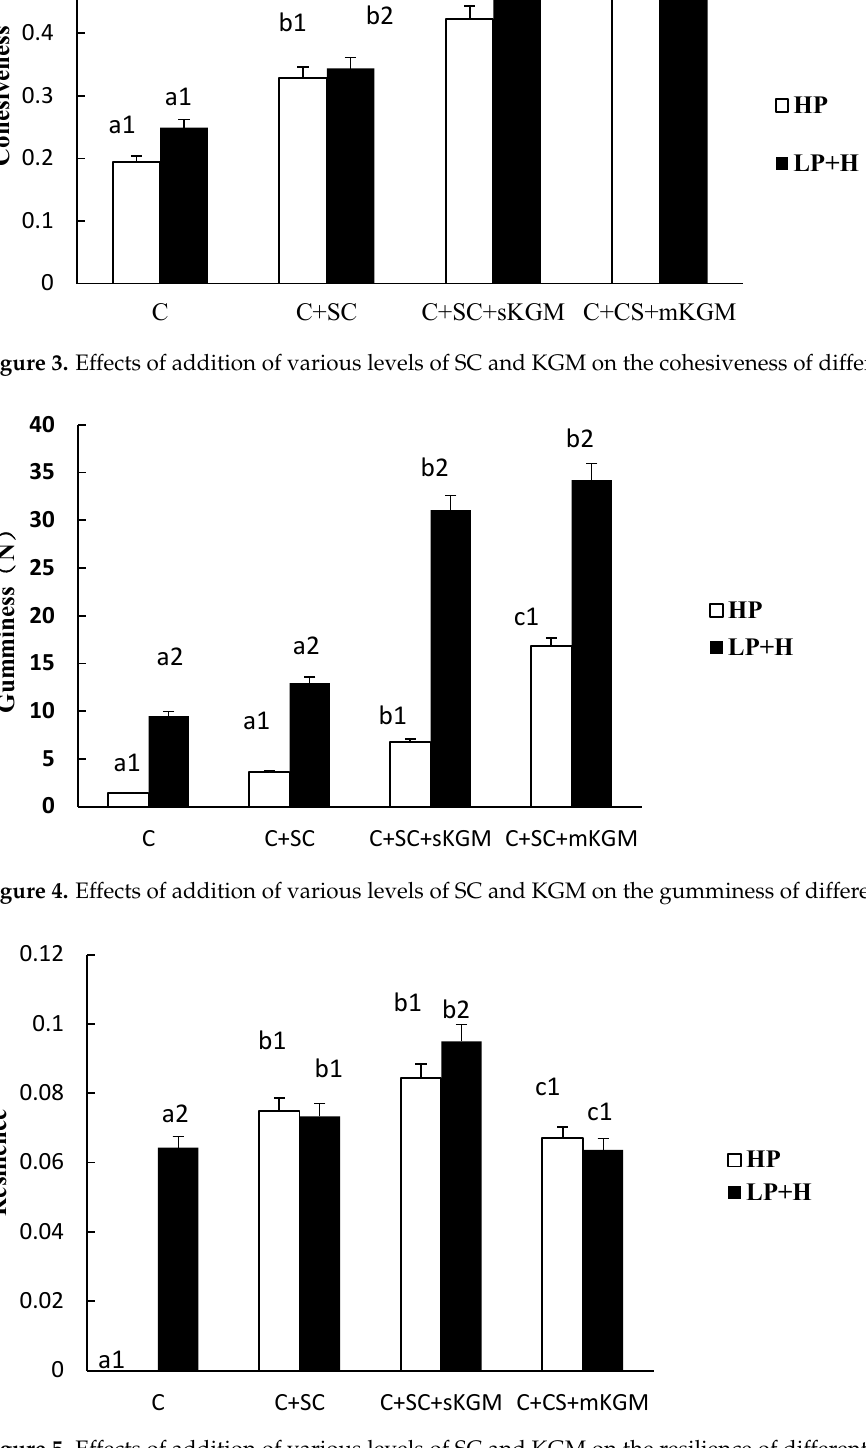
Figure 5. Effects of addition of various levels of SC and KGM on the resilience of different gels.